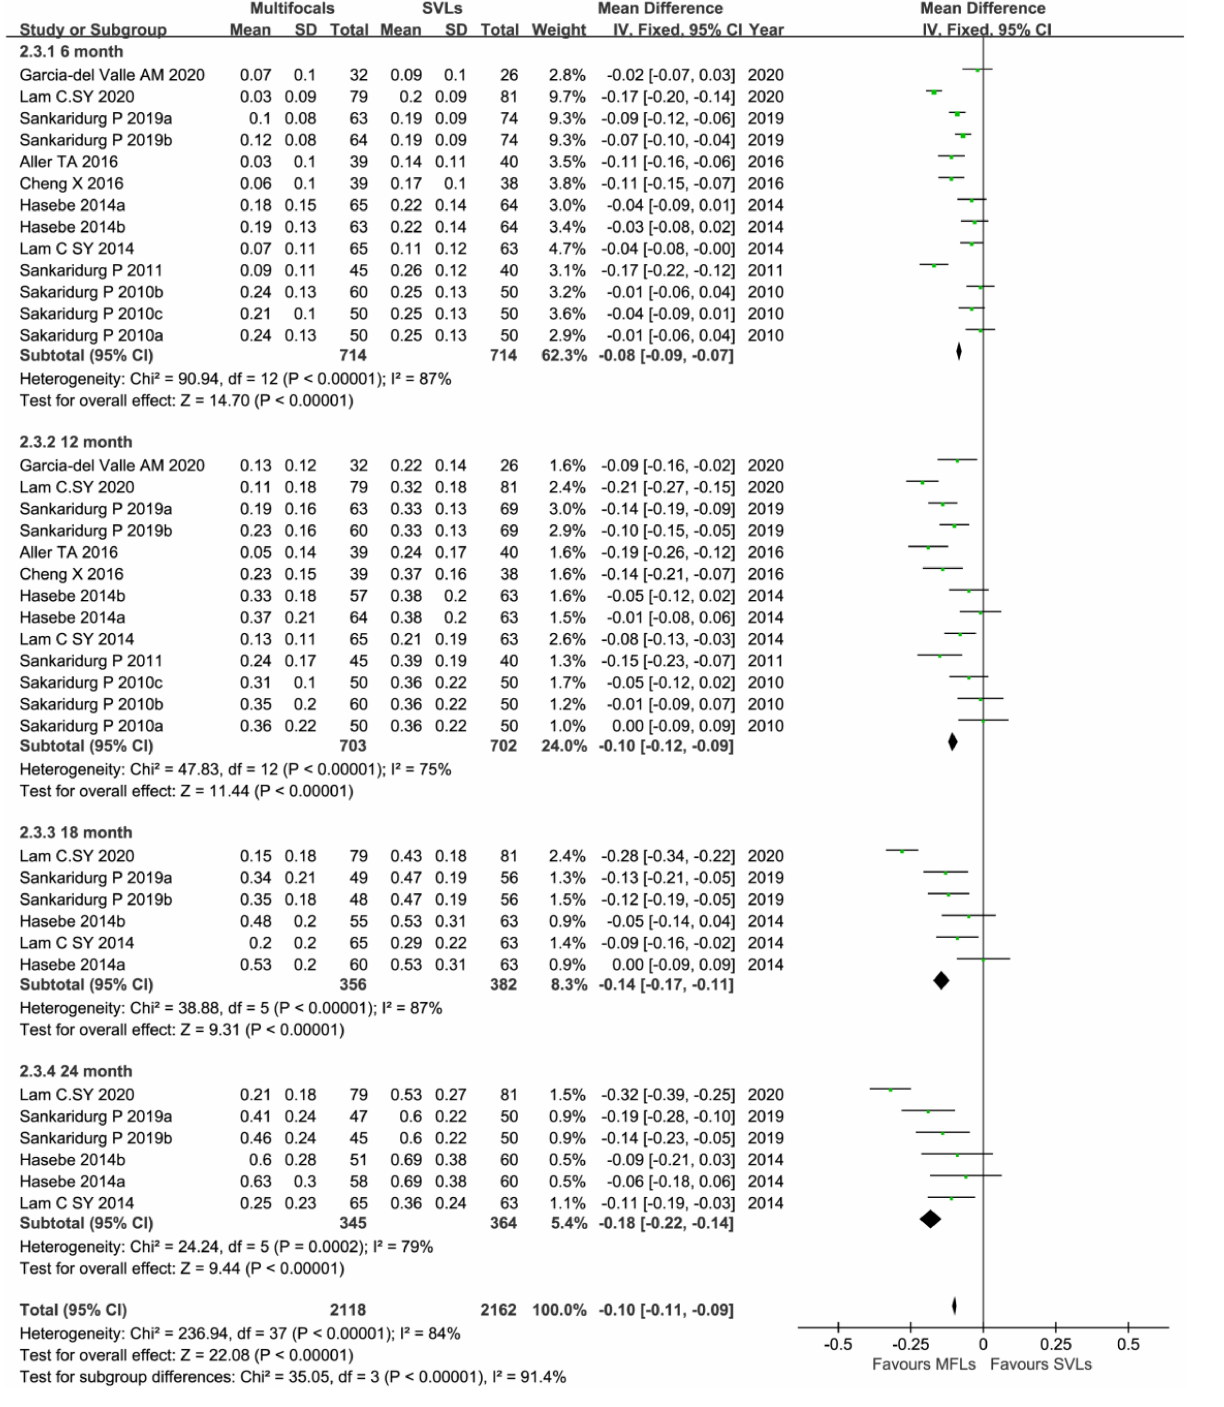
FIGURE 6 | Forest plot about the change of AL in 6-months interval visit